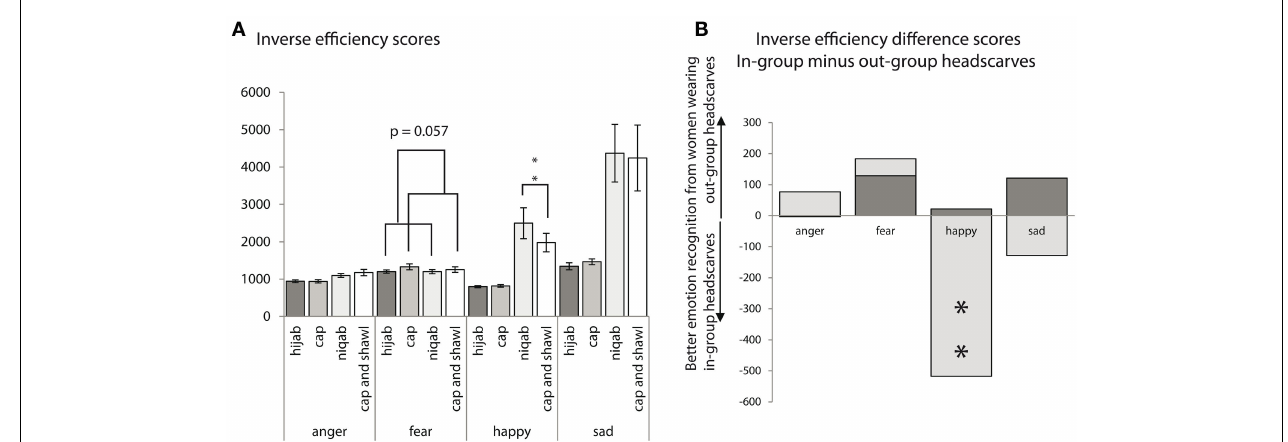
weather this was a niq ¯ ab or hij ¯ ab. (B) The graph shows the same data but difference scores are calculated of “in-group minus out-group” for inverse efficiency scores.The upper part of the graph shows conditions where the out-group was better recognized; the lower part where the in-group was better recognized.